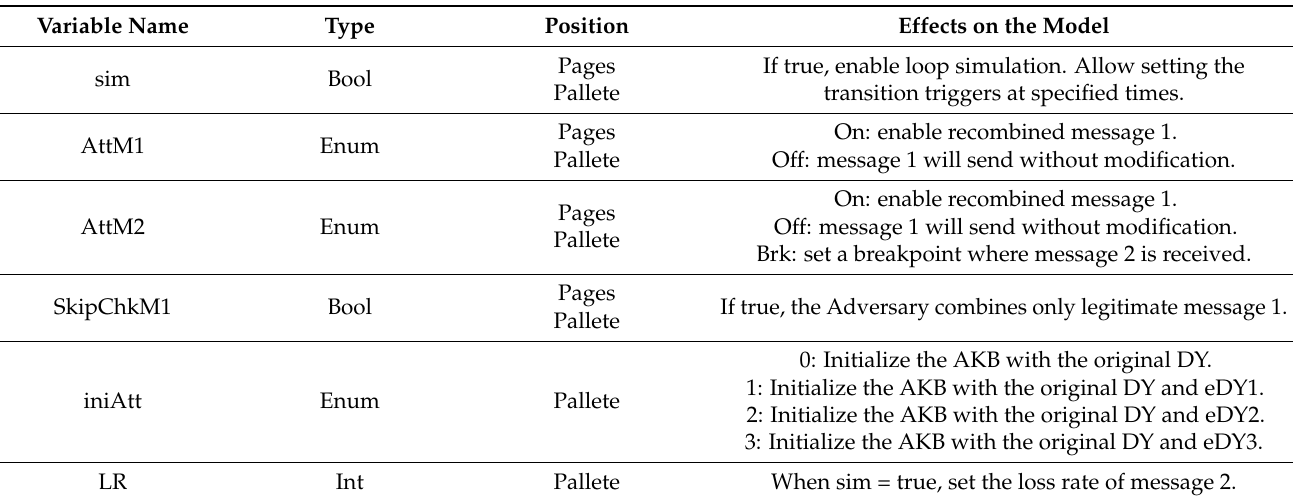
Table 2. Other initial value configurations.